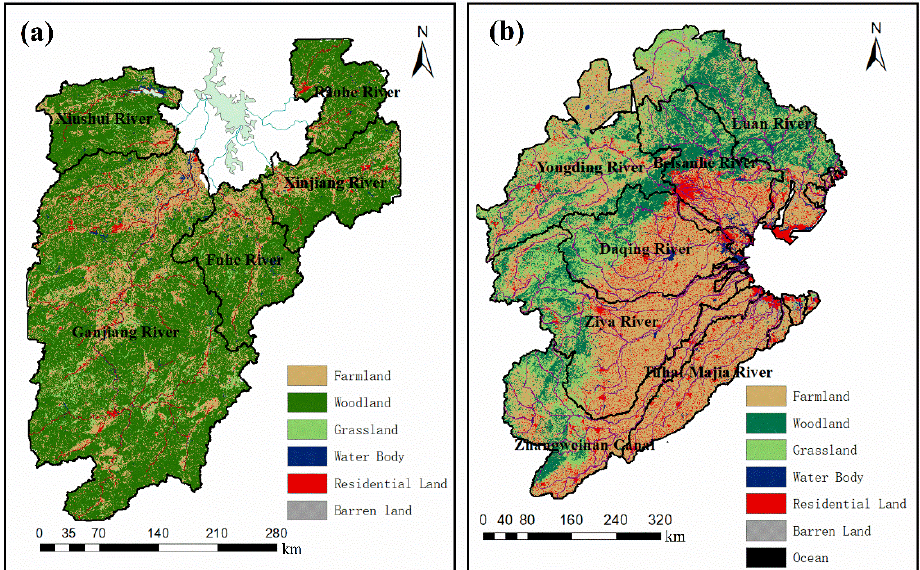
Figure 2. Land use distributions in ( a ) PLB and ( b ) HRB.